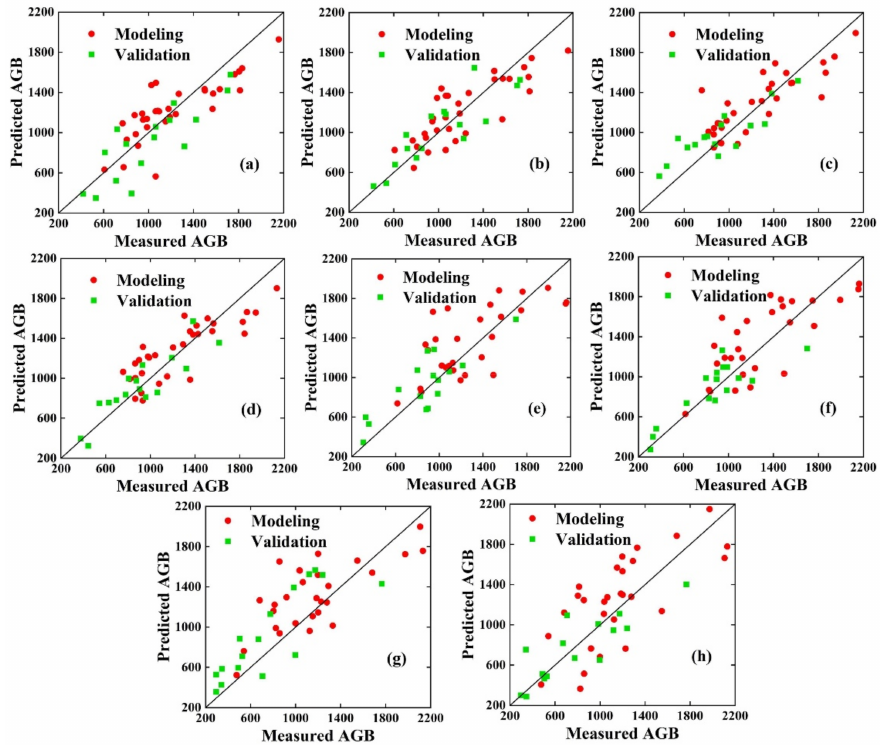
Figure 6. Relationship between measured and PLSR-estimated potato AGB (kg/hm 2 ) at different growth stages: ( a ) VIs, ( b ) VIs and optimal GEPs (tuber form stage); ( c ) VIs, ( d ) VIs and GEPs (tuber growth stage); ( e ) VIs, ( f ) VIs and GEPs (starch storage stage); ( g ) VIs, ( h ) VIs and GEPs (maturity stage).